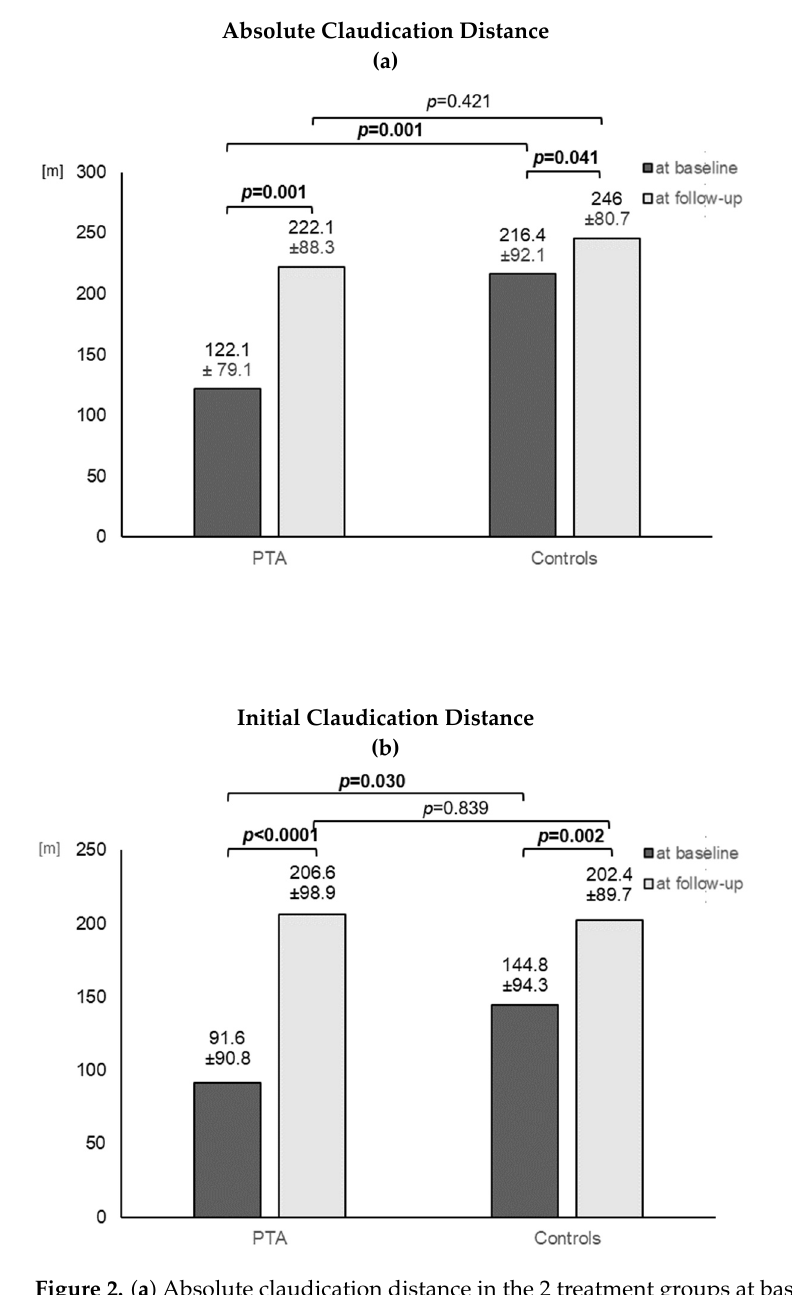
Figure 2. ( a ) Absolute claudication distance in the 2 treatment groups at baseline and at follow-up after 3 months with exercise training in both groups. Data are presented as mean and SD. ( b ) Initial claudication distance in the 2 treatment groups at baseline and at follow-up after 3 months with exercise training in both groups. Data are presented as mean and SD.